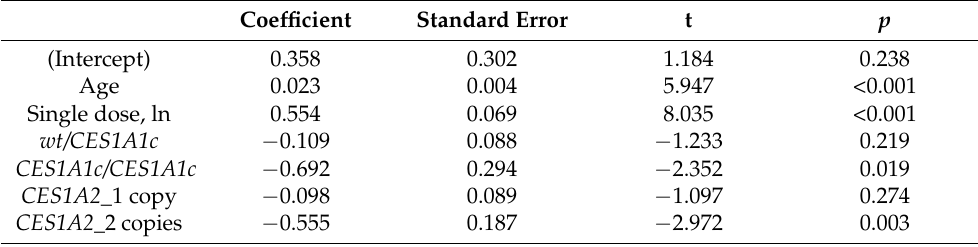
Table 4. Linear regression analysis of trough enalaprilat